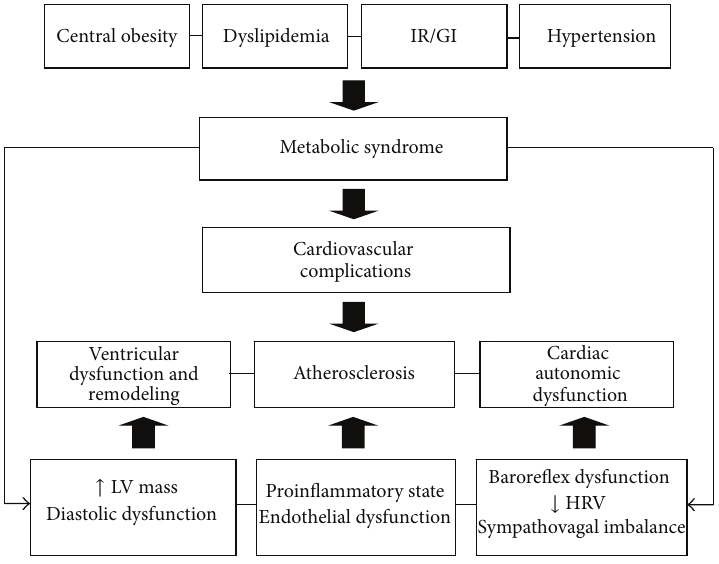
Figure 1: Components of the metabolic syndrome and its relation to the principal cardiovascular phenotypes. IR/GI: insulin resistance/glu- cose intolerance; HRV: heart rate variability; LV: left ventricular.